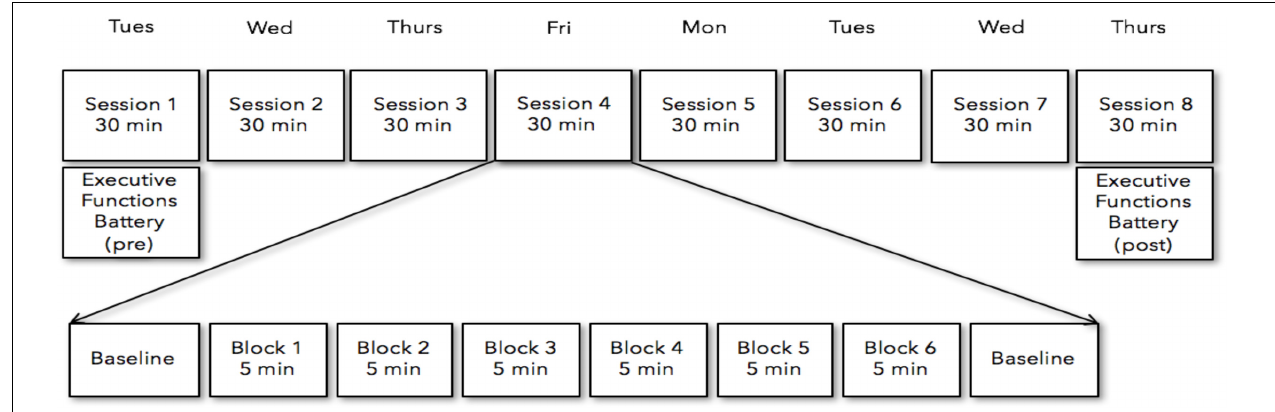
FIGURE 1 | Participants received either the neurofeedback or sham-neurofeedback training over the course of eight training from Tuesday to Friday in the first week, and from Monday to Thursday in the second week. Each Neurofeedback training session consisted of six five-min training blocks, separated by short 2–6 min breaks. The battery of tasks measuring executive functions were collected pre-neurofeedback on the first session and post-neurofeedback on the last session.